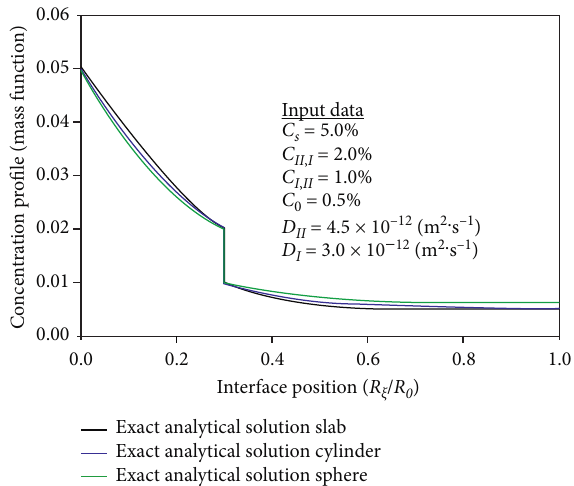
Figure 18: Comparison of concentration profiles during inward diffusion of a slab, a cylinder and a sphere as a function of di- mensionless position ( R